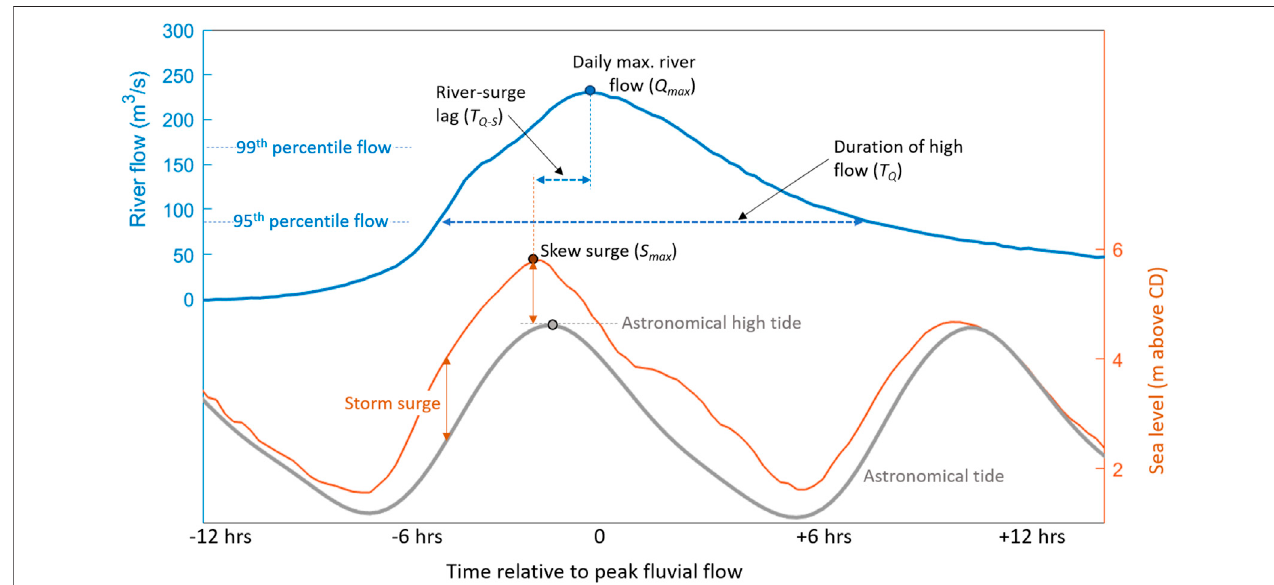
FIGURE 3 | Schematic showing de fi nition of the parameters used in the analysis.